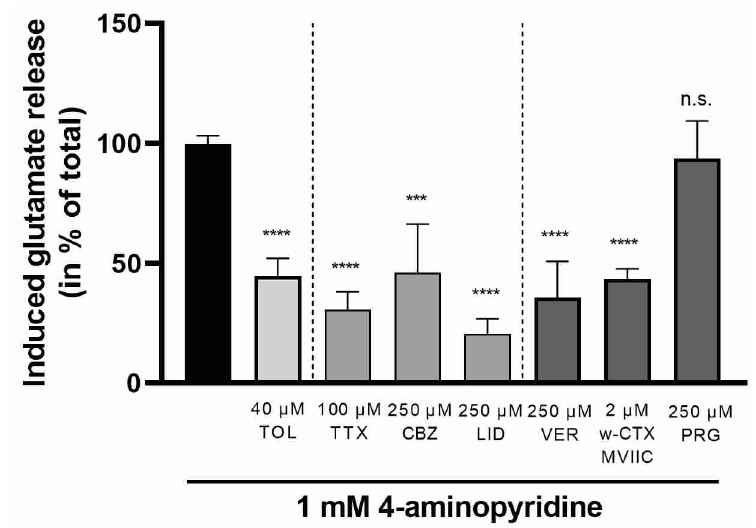
Figure 4. Effect of tolperisone, sodium channel blockers (TTX—tetrodotoxin; CBZ—carbamazepine; LID—lidocaine), and calcium channel blockers (VER—verapamil; ω -CTX— ω -conotoxin; PRG—